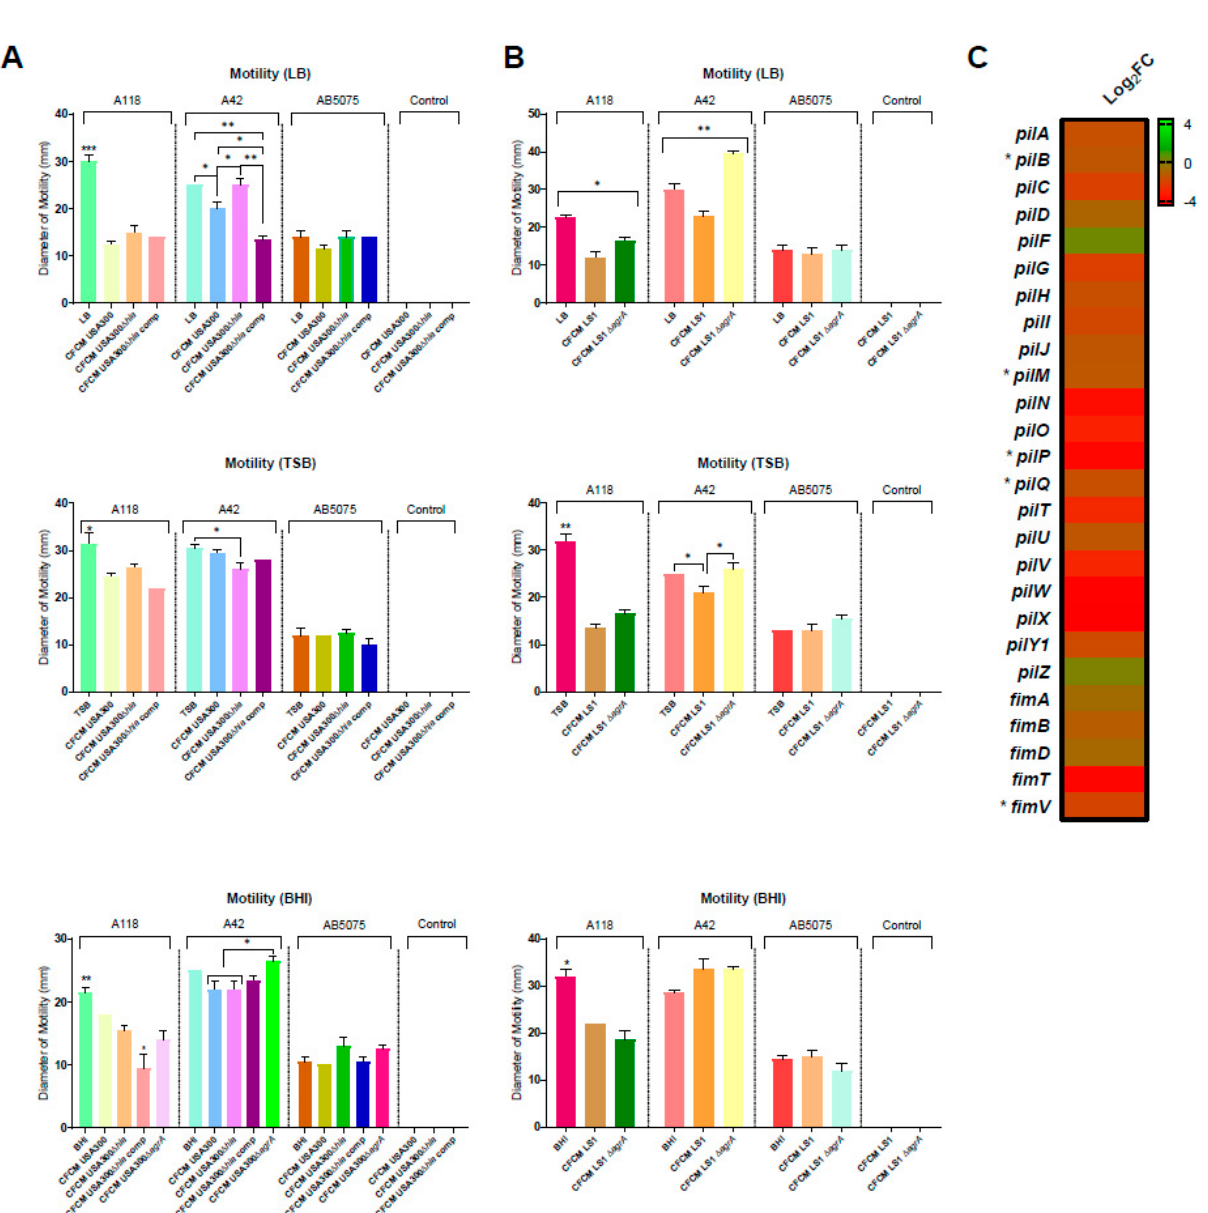
Figure 1. Phenotypic and transcriptomic analysis of associated motility coding genes. Diameter of motility (mm) of A. baumannii A118, A42 and AB5075 under CFCM USA300 , CFCM USA300 ∆ hla , CFCM USA300 ∆ hla comp or CFCM USA300 ∆ agr (only in BHI medium) ( A ) or CFCM LS1 and CFCM LS1 ∆ agr treatments ( B ) obtained from LB, TSB and BHI broth. Experiments were performed in triplicate, with at least three technical replicates per biological replicate. The control condition corresponds to LB, TSB, or BHI supplemented with CFCM, without inoculating with A. baumannii strains. Statistical analysis for each strain (ANOVA followed by Tukey’s multiple comparison test) was performed using GraphPad Prism (GraphPad software, San Diego, CA, USA), and a p -value < 0.05 was considered significant, one asterisk: p -value < 0.05; two asterisks: p -value < 0.01 and three asterisks: p -value < 0.001. The asterisks observed in the graphs indicate significant differences between the condition with one or more asterisks and the rest of the conditions, except when it is indicated with brackets between these conditions. ( C ) Heatmap showing the differential expression of genes associated with fimbriae biogenesis, structural organization of T4P and motility, and type I pilus. Significantly differentially expressed genes (DEG) are indicated with an asterisk (FDR < 0.05).